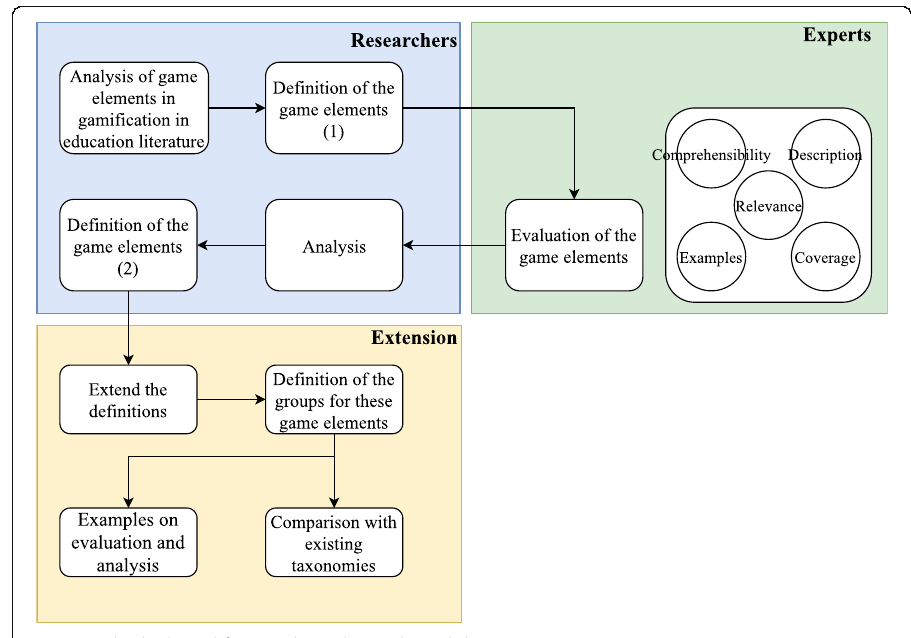
Fig. 1 Method adapted from Toda et al. (2019b) and the